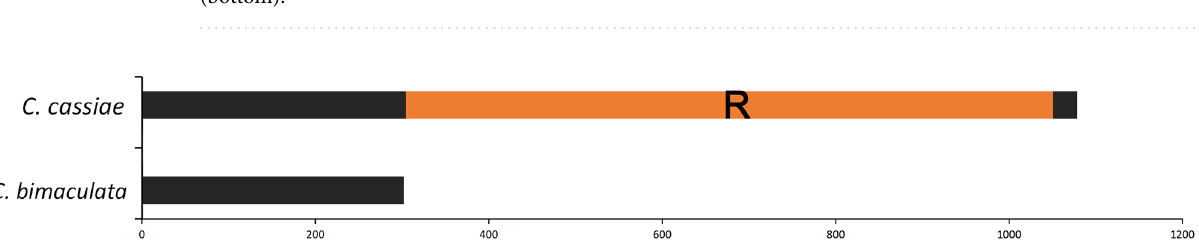
Figure 3. Structural organization of the Control region of C. cassiae and C. bimaculata. R: repeat